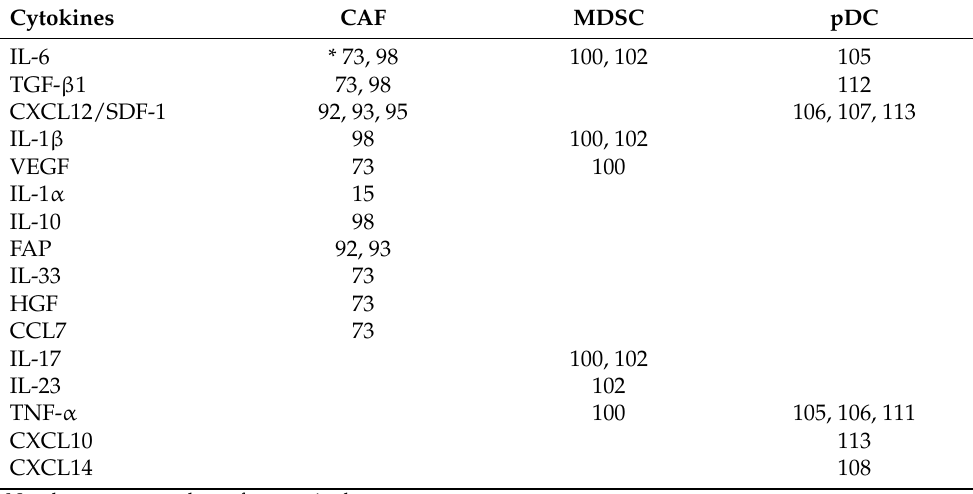
Table 4. Cytokines mediating cross-talks among HNSCCs and immune-suppressive stromal